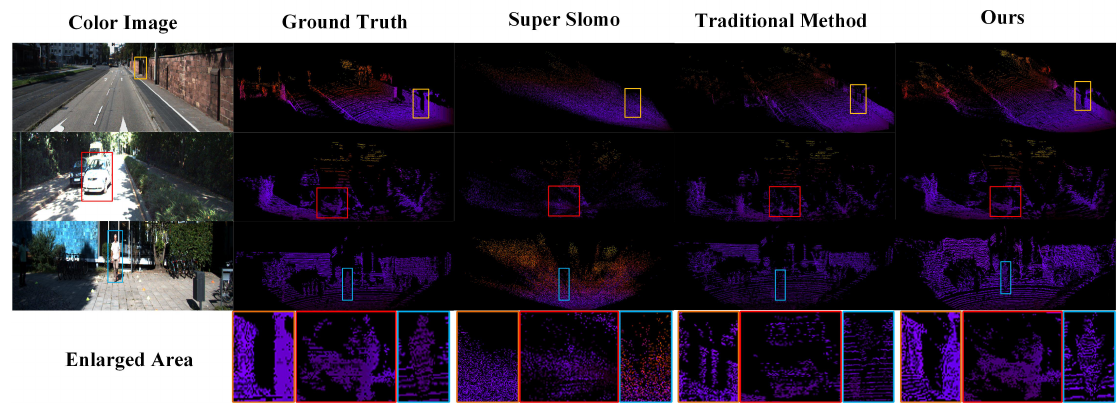
Figure 5. Visual comparisons of the point cloud obtained by different methods. We show the intermediate color images, ground truth, and interpolation result of Pseudo-LiDAR point clouds by three methods. Our model produces outlines and boundary regions for small objects (such as cars and people) that are more similar to ground